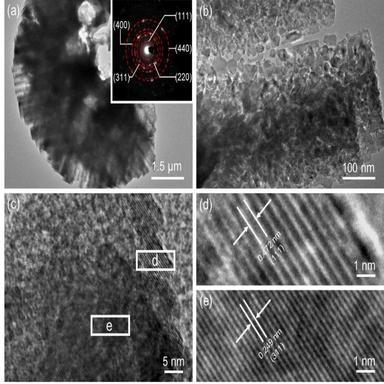
(a, b) TEM images and (c–e) HRTEM images of MnCo2O4-discs; inset of (a) shows the SAED pattern.